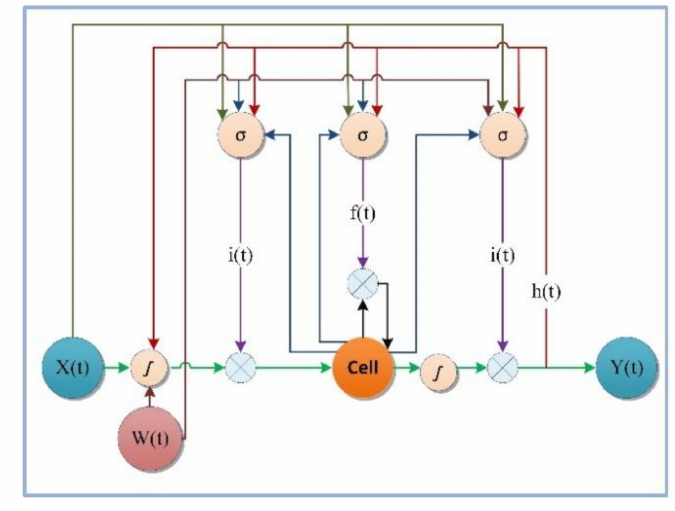
Figure 3. LSTM Architecture.